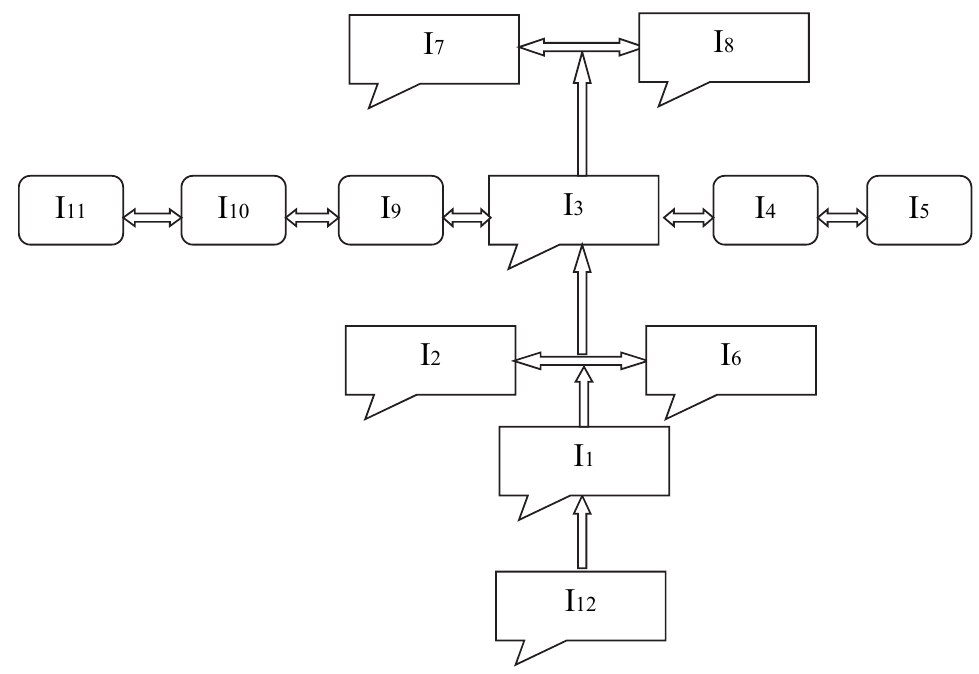
Fig. 3. Diagraph for the present